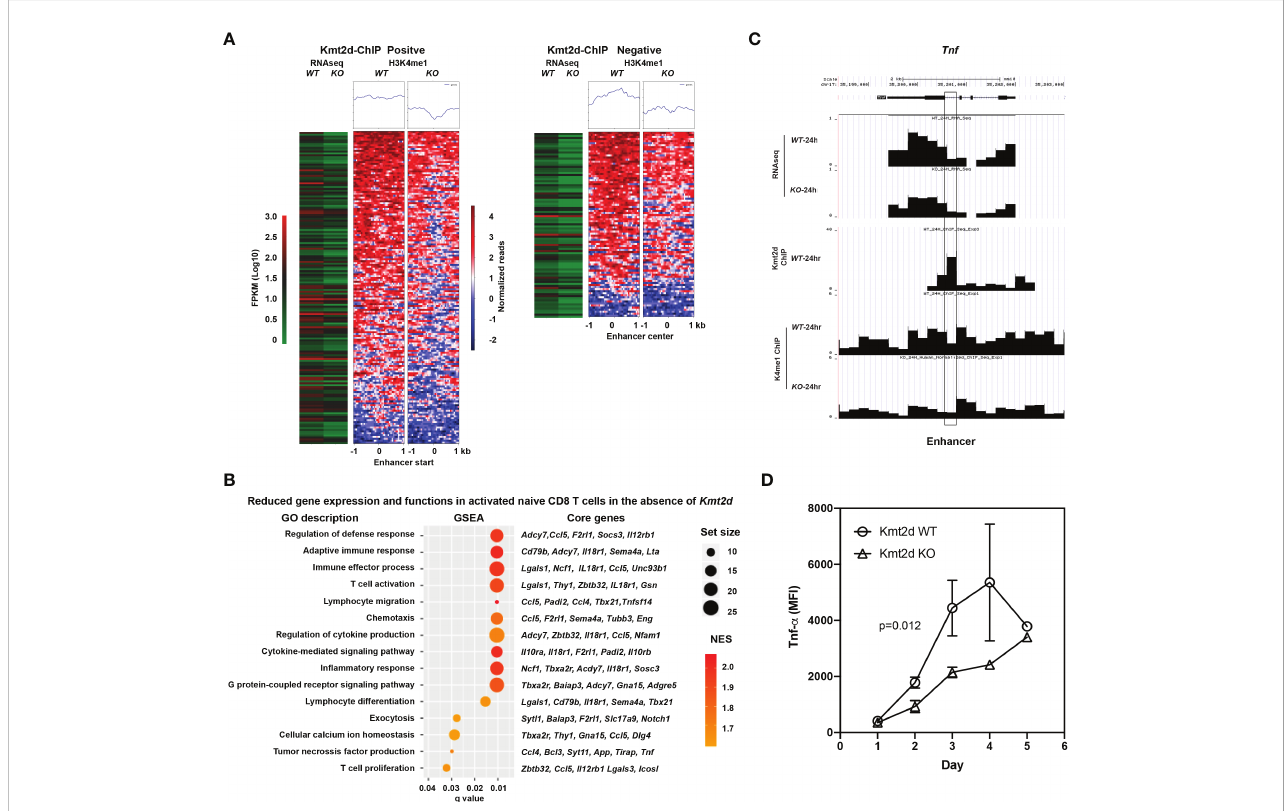
FIGURE 4 Reduced levels of H3K4me1 in enhancer regions and corresponding gene expression in activated naïve CD8 + T cells of Kmt2d KO mice. (A) Reduced gene expression associated with reduced H3K4me1 level in enhancer in Kmt2d KO activated naïve CD8 + T cells after stimulation. Naïve CD8 + T cells from spleen of both Kmt2d WT and Kmt2d KO mice by FACS-sort and stimulated in vitro by a CD3/CD28 antibody for 24 hours. Stimulated cells were harvested for RNAseq, ChIPseq of H3K4me1 and Kmt2d. Number of reduced expressed genes in Kmt2d KO mice along with H3K4me1 level and with (N=167) or without (N=90) Kmt2d binding are presented. (B) Selected reduced functions based on gene expression changes in activated naïve CD8 + T cells between Kmt2d WT and Kmt2d KO mice. Gene set enrichment analysis (GSEA) was used and signi fi cantly reduced GO functional groups (q<0.05) and their core changed genes along with gene set size, normalized enrichment score (NES), and q values are presented. (C) Expression (RNAseq), H3K4me1 level, and Kmt2d binding on Tnf gene. Gene track and ChIP-seq reads are presented and enhancer is marked. (D) TNF- a expression in stimulated naïve CD8 + T cells from Kmt2d WT and Kmt2d KO mice. TNF- a expression in stimulated naïve CD8 + T cells were determined by intracellular staining and fl ow cytometry. The median fl uorescent intensity (MFI) was presented at each indicated time